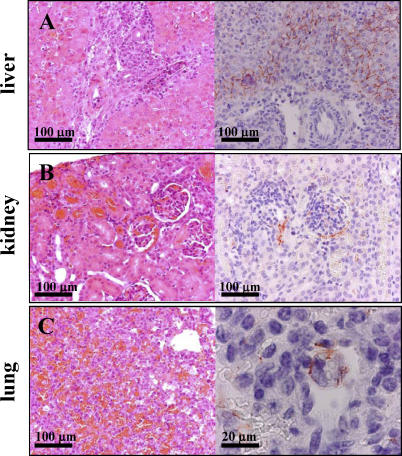
Histopathologic sections on Liver, Kidney, and Lung of Guinea Pigs Infected by Complemented Strain TK2 6 d Post-InoculationLeft panel: Hematoxylin and eosin staining (×200) of infected guinea pigs. Right panel: Immunochemistry with antiserum specific for LipL32 (×200; except [C], ×1,000). Pictures of histopathology were similar between animals infected with wild-type and complemented strains.(A) The liver has a great loss of architecture and areas of necrosis and inflammatory infiltration, which are both associated with the presence of numerous leptospires.(B) Kidneys present hemorrhages, tubular necrosis, and inflammatory infiltration, with leptospires mainly located in Bowman's spaces and proximal tubules.(C) Lungs have marked intra-alveolar hemorrhages with inflammatory infiltrates, and few leptospires are present within septal membranes and, sometimes, in macrophages ([C], right panel).